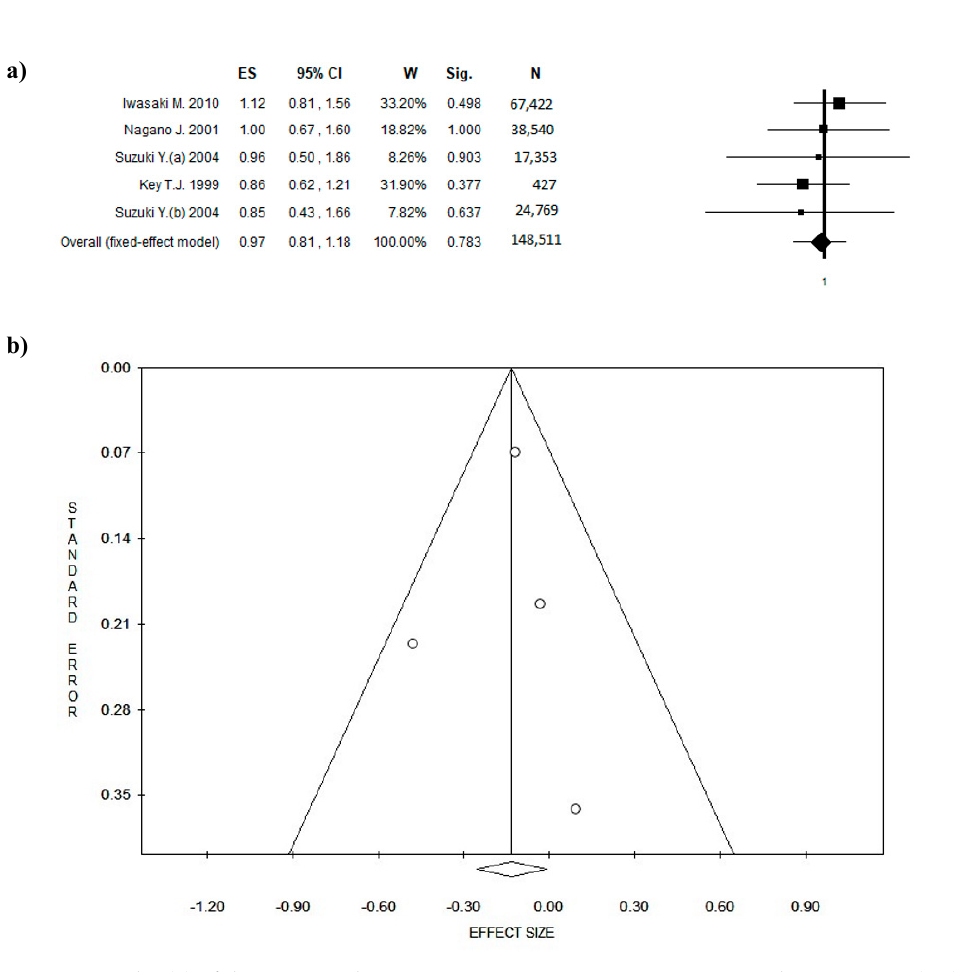
Figure 6. Forest plot ( a ) of the meta-analysis comparing green tea consumption in breast cancer (BC) (women in pre-menopausal status). Funnel plot ( b ). Abbreviations: ES= effect size; CI= confidence interval; W= weight; Sig= significance; N= number.